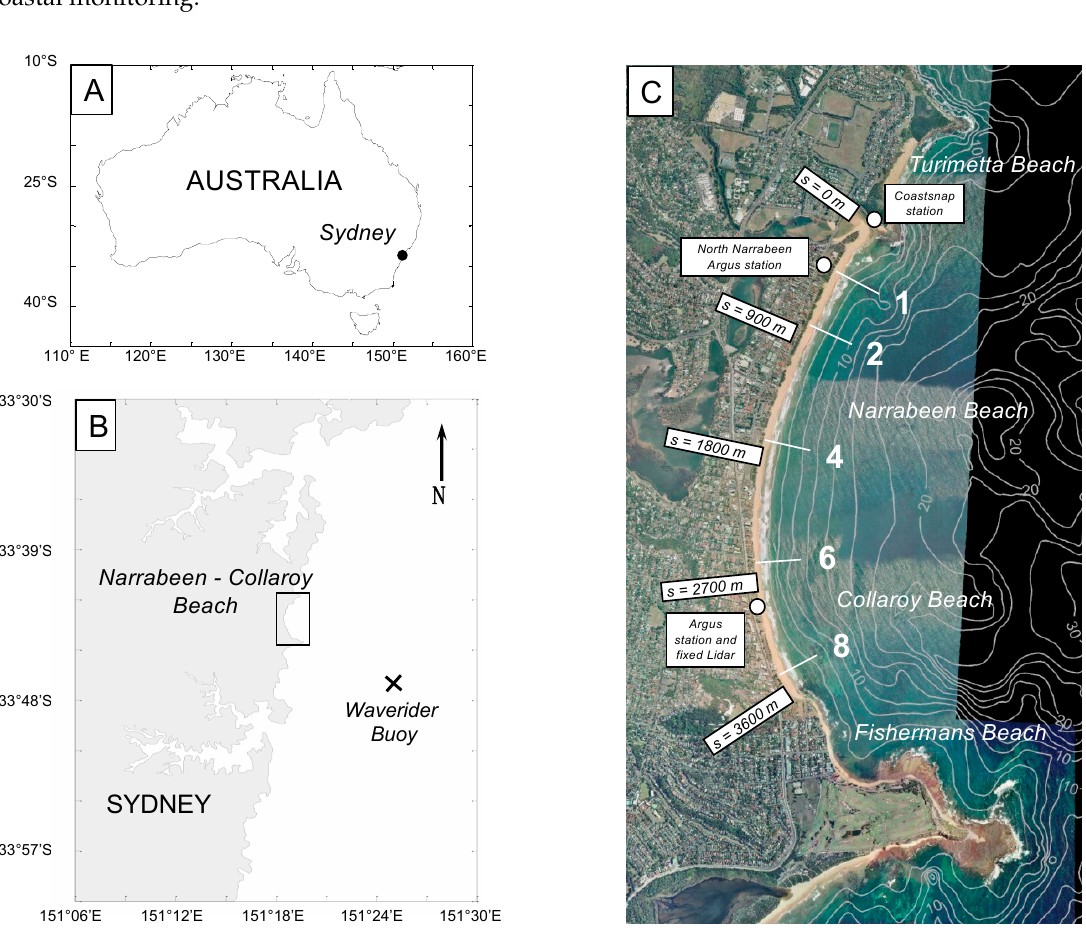
Figure 1. Location figure. ( A ) Location of Sydney in Australia. ( B ) Location of Narrabeen-Collaroy Beach within the Sydney region. ( C ) Narrabeen-Collaroy Beach, indicating the locations of the five historical survey profiles (1, 2, 4, 6 and 8) as well as the permanent and temporary Argus stations, fixed Lidar and CoastSnap station.